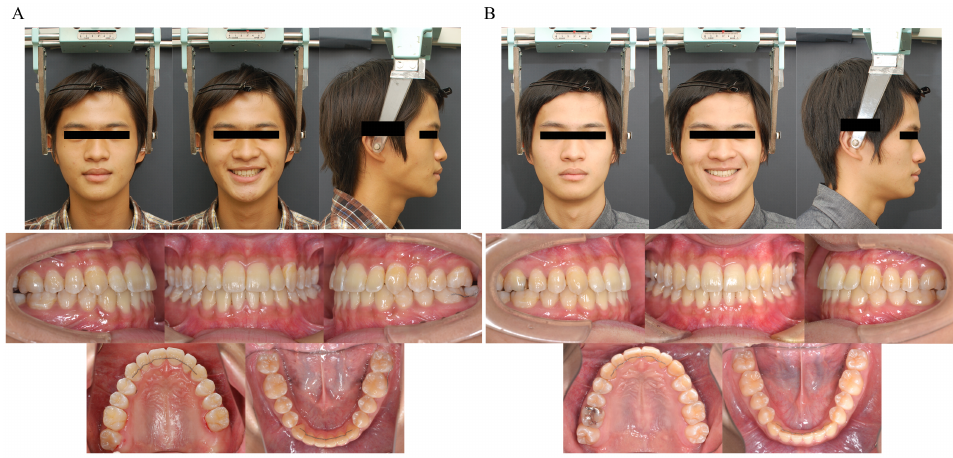
Figure 7. Facial and intraoral photographs. ( A ) At termination of active treatment (age, 17 years